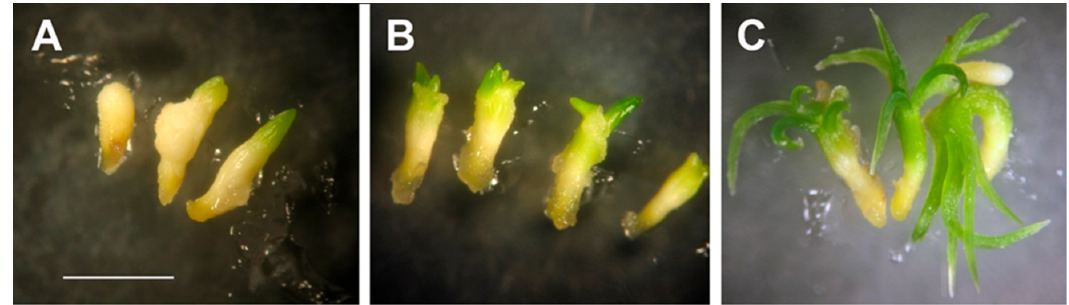
Figure 5. Morphological deformations of P. abies somatic embryos (as an example). ( A,B ) Embryos with swollen hypocotyl and/or lacking some cotyledons and ( C ) precociously germinated embryos. Bar = 1 mm.